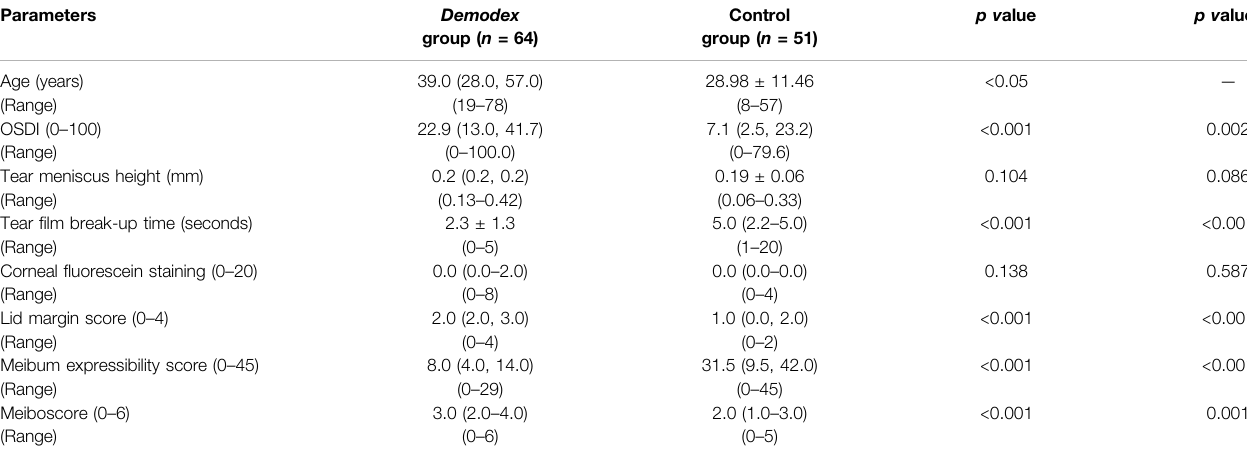
TABLE 1 | Basic characteristics and the clinical parameters of the subjects in Demodex group and control group. Parameters